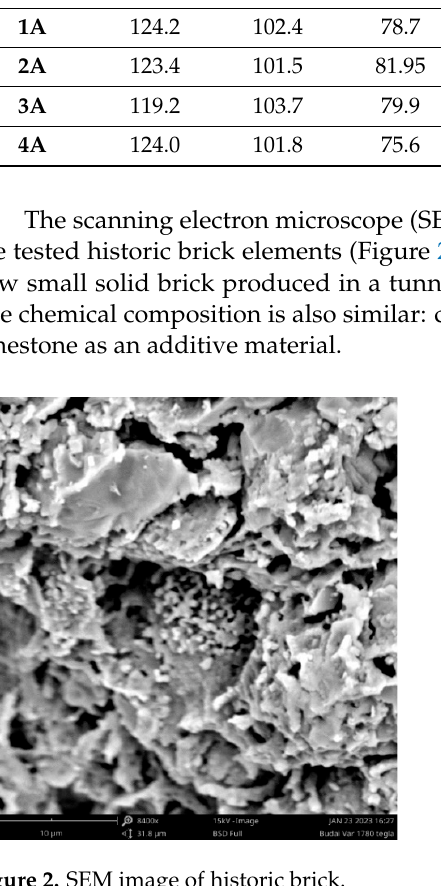
Table 3. The specimen’s dimensions after cut.